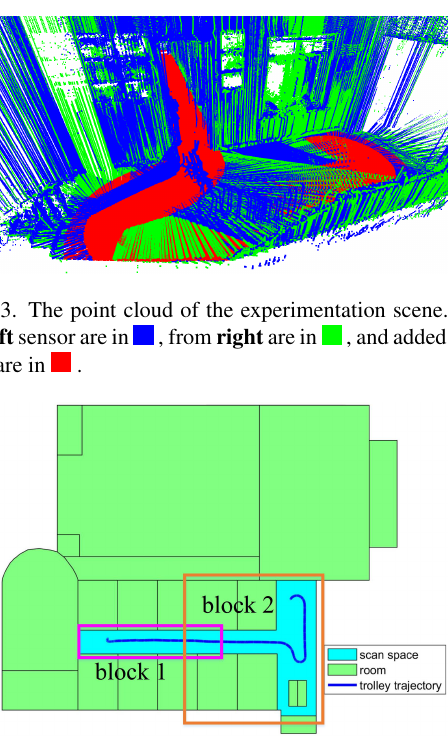
Figure 4. Trajectory of the trolley and blocks division.